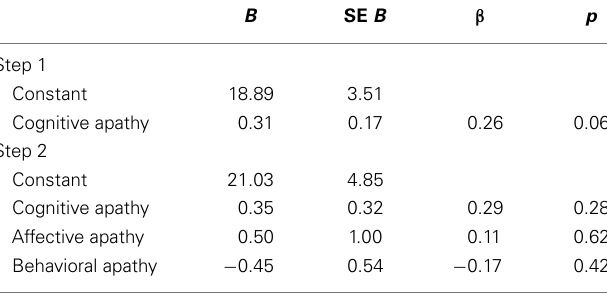
Table 6 |Apathy domains and the Brixton test .